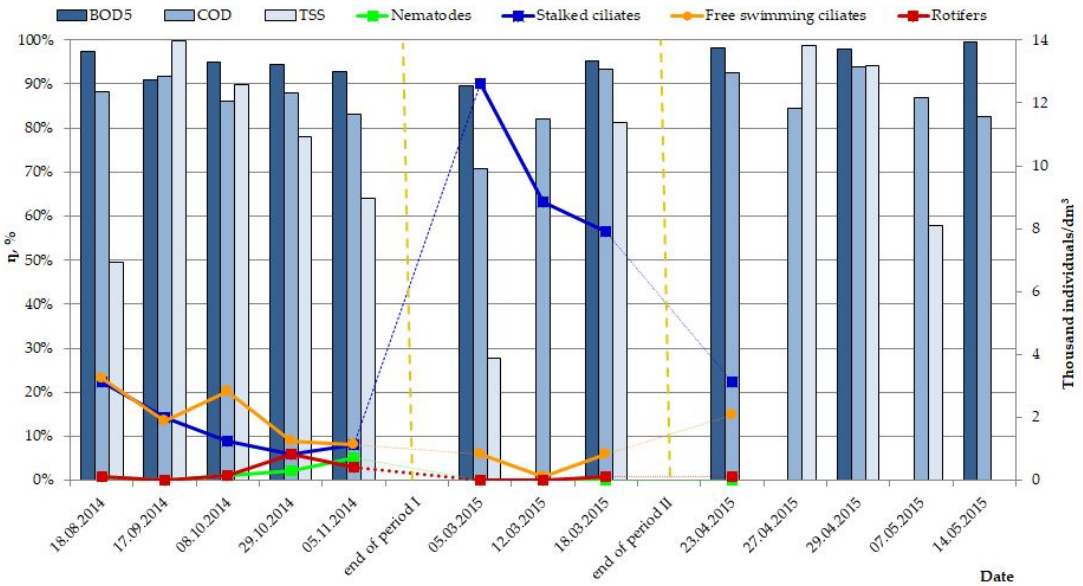
Figure 5. Abundance of organisms in the activated sludge, efficiency of organic compounds removal, and efficiency of total suspended solids removal in WTP1.